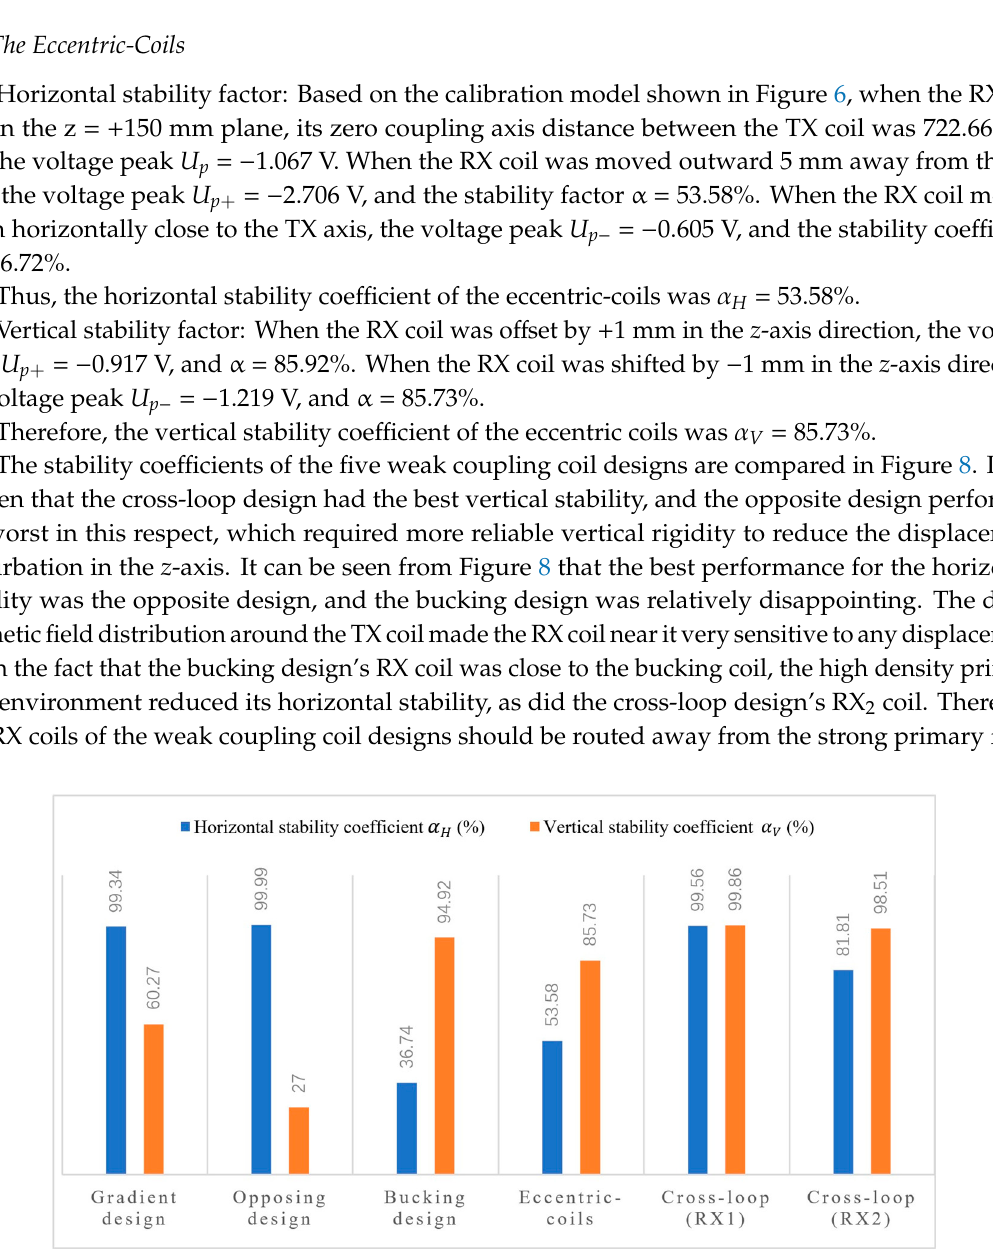
Figure 8. Comparison of the stability coe ffi cients of five weak coupling coils. The horizontal stability coe ffi cient α H is displayed as a blue histogram, and the vertical stability coe ffi cient α V is displayed as an orange histogram. The best performance for the horizontal stability is the opposite design, and the bucking design is relatively disappointing; while the cross-loop design gas the best vertical stability, and the opposite design performs the worst in this respect.